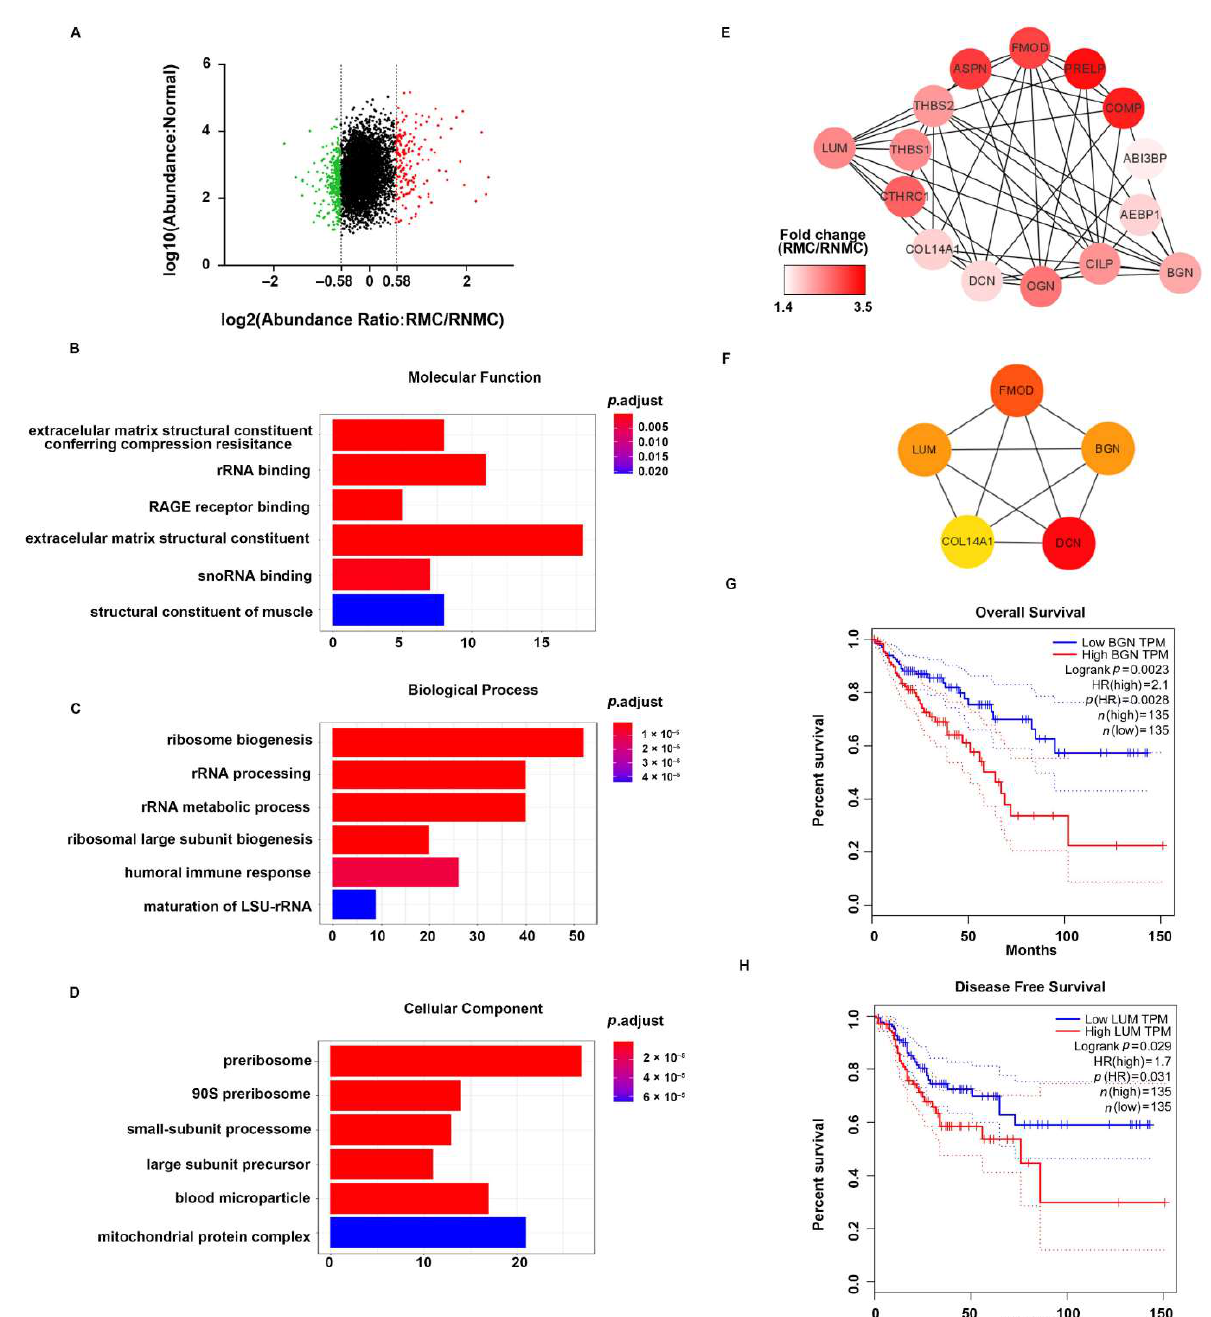
Figure 4. Functional analysis of DEPs between RMC and RNMC. ( A ) Scatter plot showing the distribution of upregulated (red dots) and downregulated (green dots) differentially expressed proteins (DEPs). ( B – D ) GO analysis indicated enrichment of these DEPs in molecular function (MF), biological processing (BP), and biological cellular component (CC). ( E ) The ECM-related DEPs in the protein–protein interaction networks are shown as nodes (MS data presented as the 129/131 ratios were matched to STRING networks). The intensity of the red color indicates the ratio of protein abundance in RMC/RNMC. ( F ) The hub proteins of ECM-related DEPs identified by the MCODE plug-in in RMC. The Kaplan–Meier survival analysis indicated inferior overall survival and disease-free survival among colon cancer patients with high expression of BGN and LUM, respectively. ( G ) The elevated BGN mRNA expression in colorectal cancer is positively associated with poor prognosis (log-rank test p = 0.0023). ( H ) The elevated LUM mRNA expression in colorectal tumor tissues is also positively associated with poor prognosis (log-rank test p = 0.029).